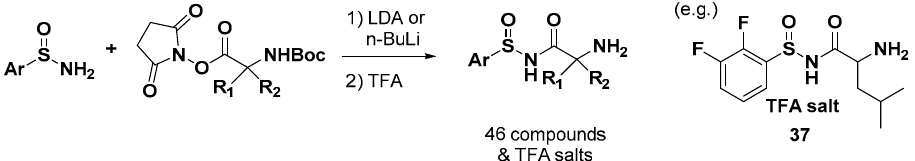
Figure 14. Synthesis of 2-amino- N -(arylsulfinyl) acetamide compounds and the structure of the prokaryotic LeuRS inhibitor 37 .